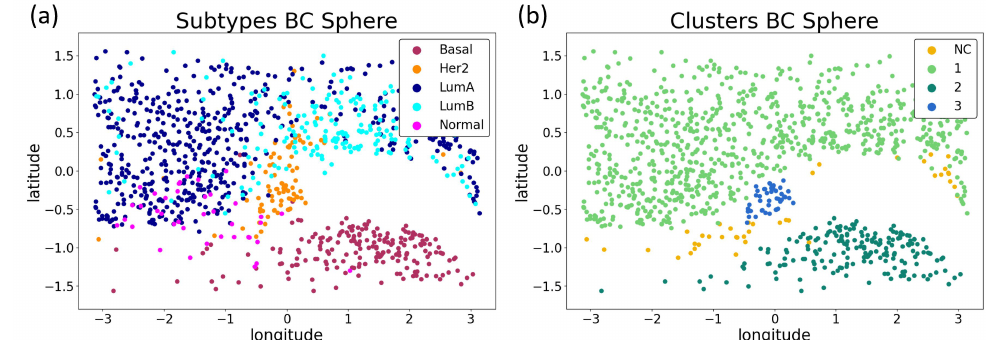
Figure 5. Visualization of the best UMAP embedding. Two-dimensional spherical surface mapped by UMAP with NN equal to 65 (see Table A2 in Appendix A). The points correspond to the BC samples. In ( a ) on the left, the color indicates the tumor subtype, whose acronym is shown by labels, for a total of 5 BC types. In ( b ), the colors refer to the different clusters identified by our method for HDBSCAN, for a total of 4 groups. Latitude and longitude are the commonly used coordinates to identify a point (i.e., a sample) on the spherical surface, expressed in radians. NC stands for the cluster constituted by Not Clusterable points (see Methods